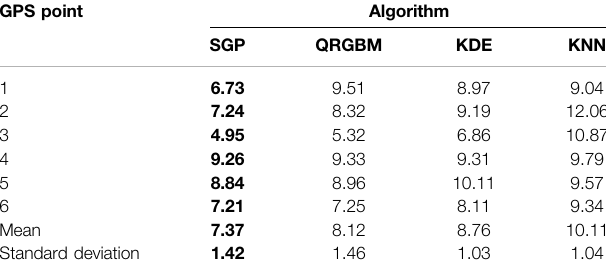
TABLE 1 | Summary of CRPS for all probabilistic algorithms